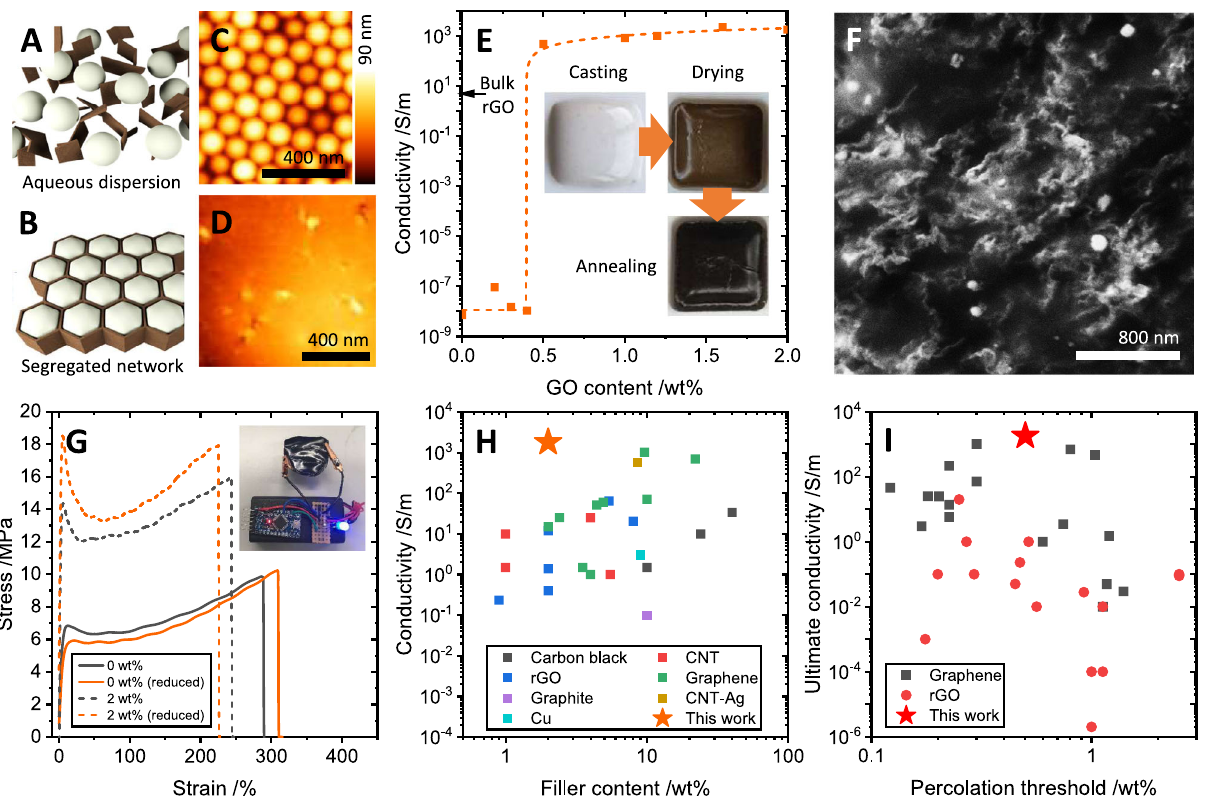
Fig. 1 | Assembly and properties of segregated network nanocomposites. A , B Schematicsofthecompositelatex-GOdispersionandsubsequently-templated fi lm structure. C , D Atomic force micrographs of a latex fi lm before and after heatingabovetheglasstransitiontemperatureofthepolymer,resultinginparticle coalescence. E Achieved conductivity in the latex-GO composites post-reduction. Indicated is the conductivity of a bulk rGO fi lm processed under the same condi- tions. (inset) Photographs of the sample at each processing step. F Scanning electron micrograph of a fracture surface of a post-reduction composite.